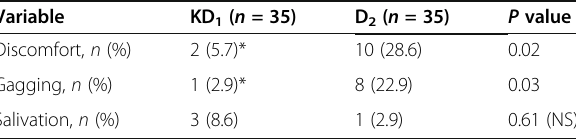
Table 4 Postoperative side effects in the two studied groups Variable